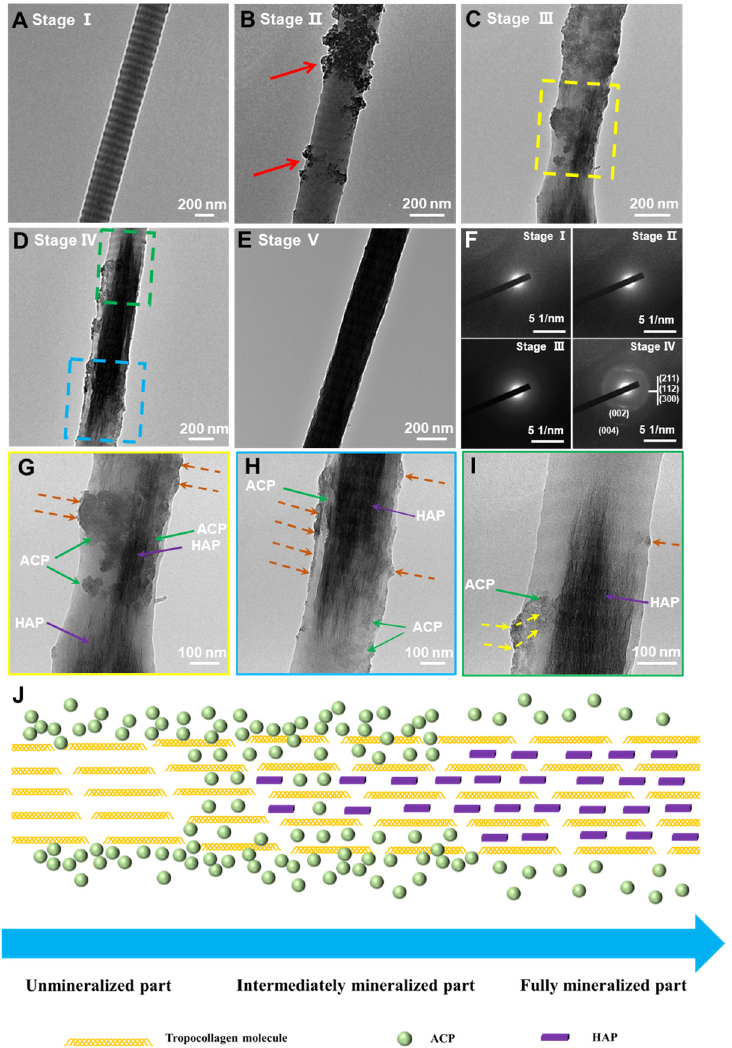
Figure 4. The process of intrafibrillar growth of HAP nanocrystals. ( A – E ) Five stages (I–V) of the growth of HAP nanocrystals in a collagen fibril ( A ) Stage I: Original collagen fibril. ( B ) Stage II: ACPs (marked with red arrows) absorb on collagen. ( C ) Stage III: ACPs infiltrate the collagen fibril and begin to transform into HAP. ( D ) Stage IV: Plenty of HAP is formed inside the collagen fibril. ( E ) Stage V: The collagen fibril with the full growth of HAP nanocrystals. ( F ) SAED patterns of stages I–IV. ( G ) High-magnification image of the yellow dotted box in ( B ). ( H , I ) High-magnification images of green dotted box area and blue dotted box area in ( D ), respectively. The orange arrows in ( G , H , I ) indicates the ACPs on the surface of collagen fibrils ( J ) Schematic diagram of the process of growth of HAP nanocrystals in